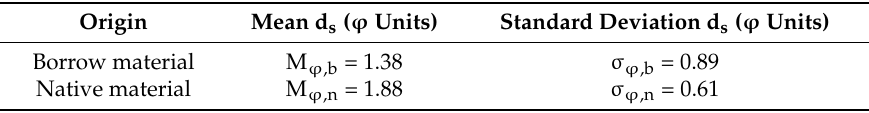
Table 6. Average grain size characteristics for both borrow and native